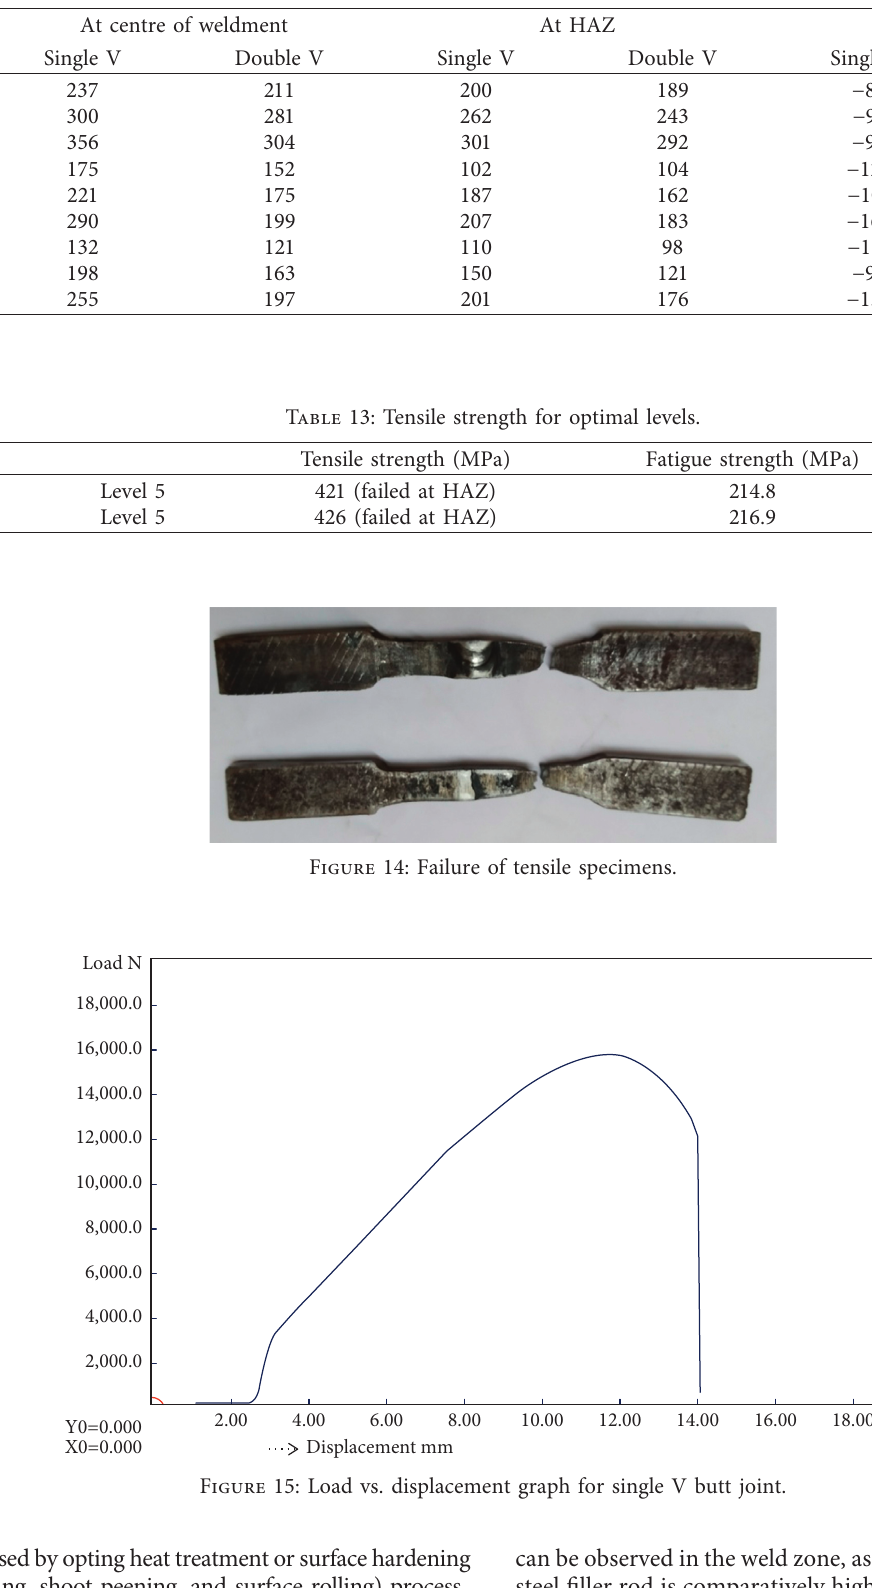
Table 12: Residual stresses (MPa).